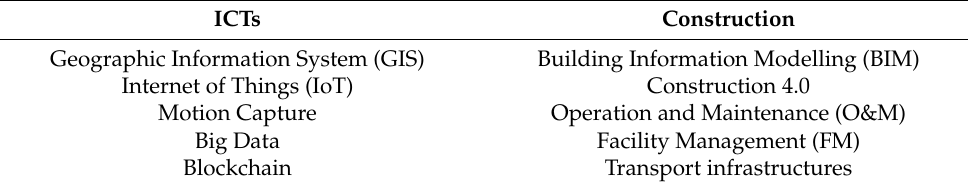
Table 1. Main keywords